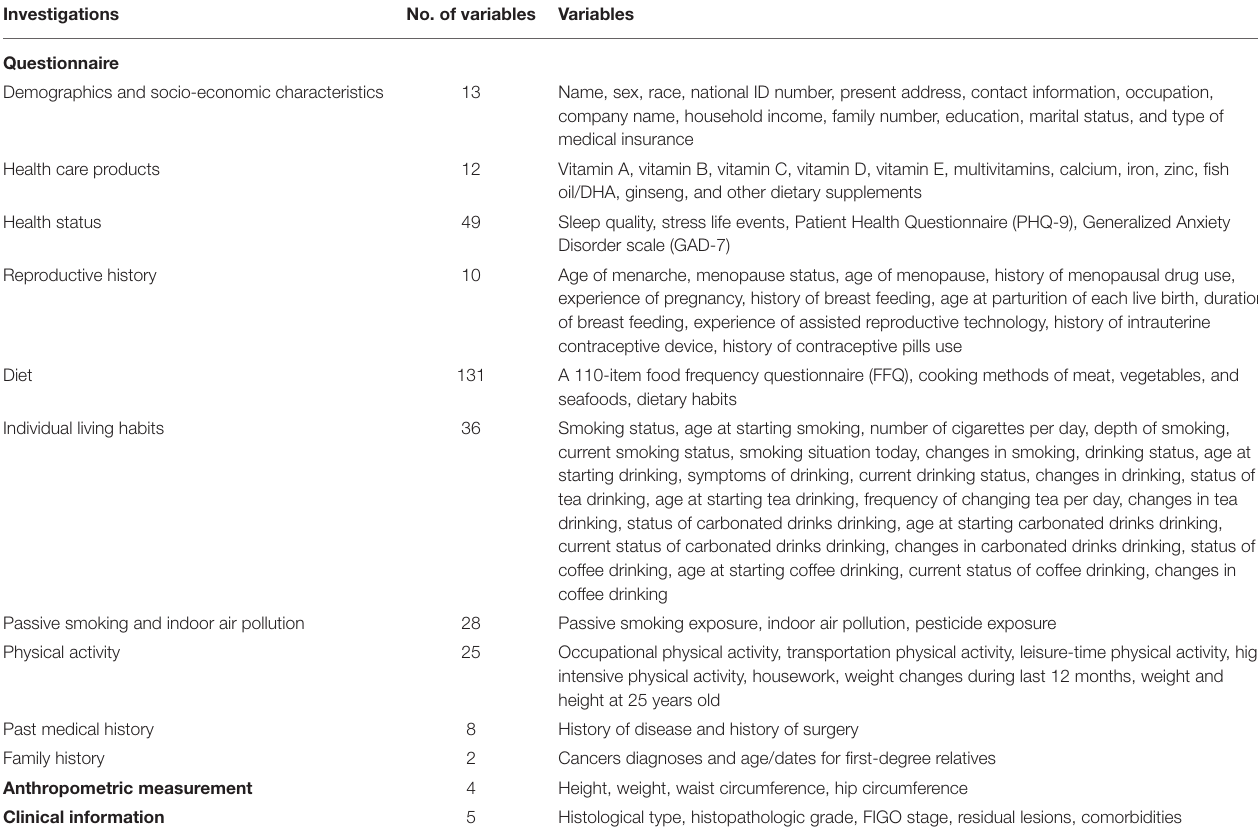
TABLE 1 | Summary of investigations at the baseline survey.